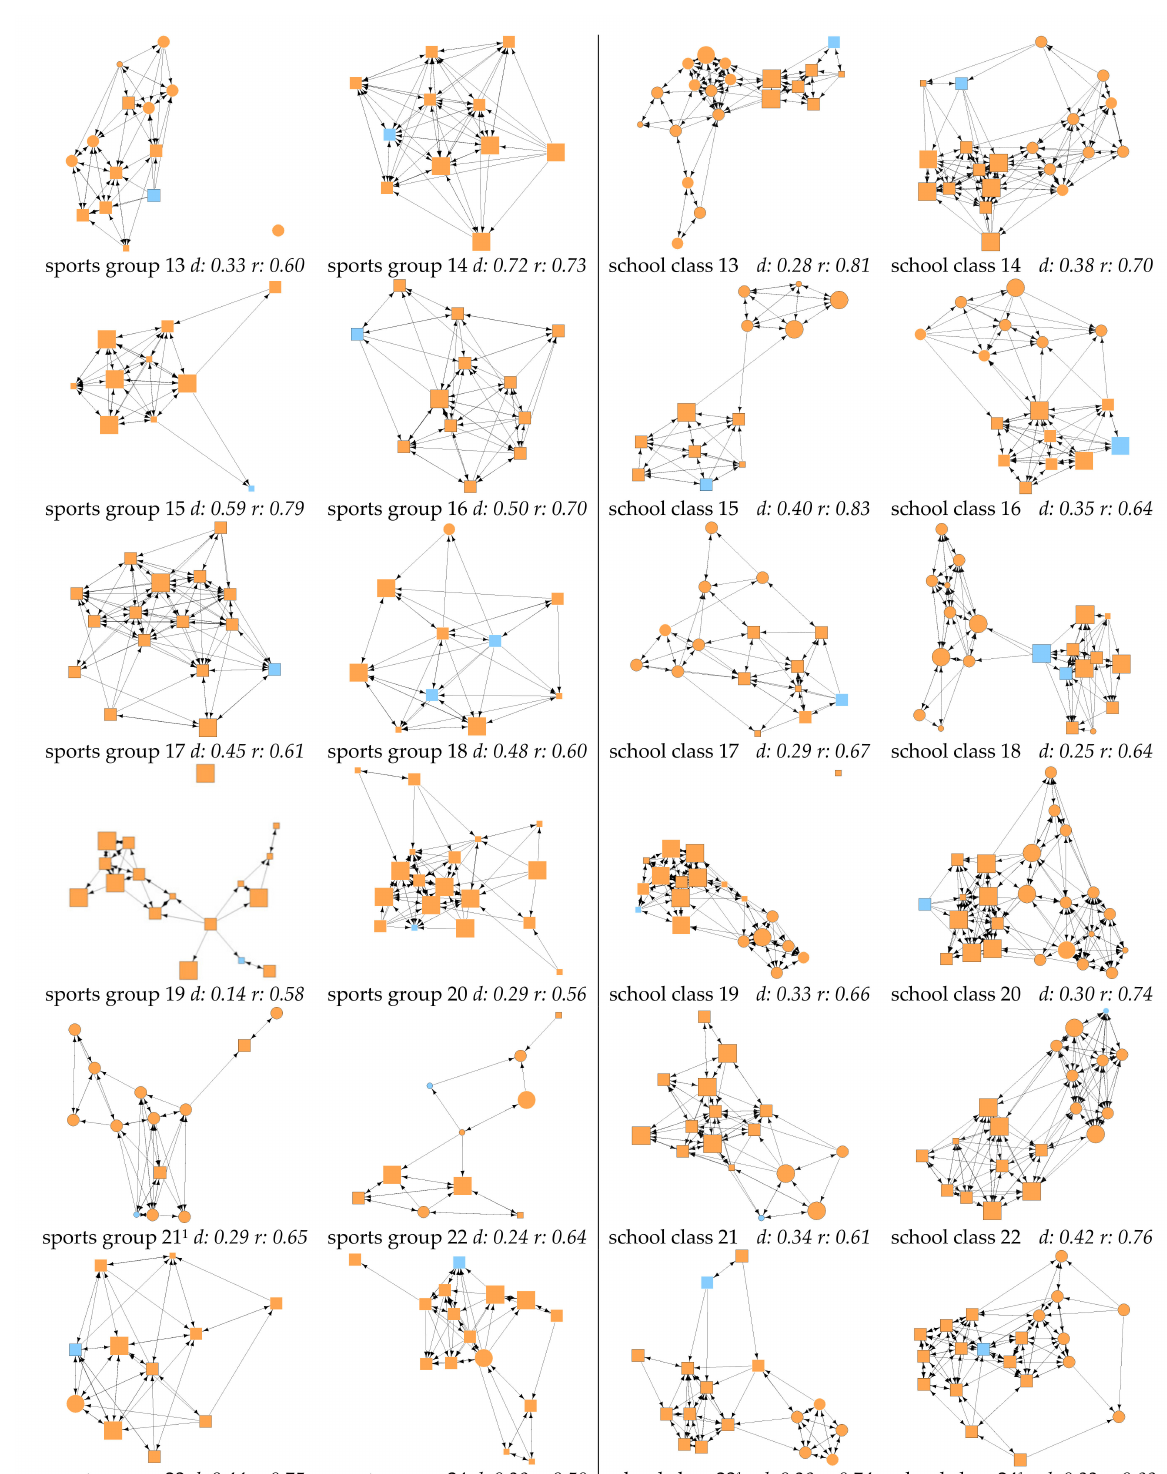
Figure 2. Continued friendship networks. 1 With sports group 21, school class 23 and school class 24, missing values in athletic ability were replaced with the average for visualization purposes. For model estimation, athletic ability was not included with the aforementioned networks (see Table A1 in Appendix